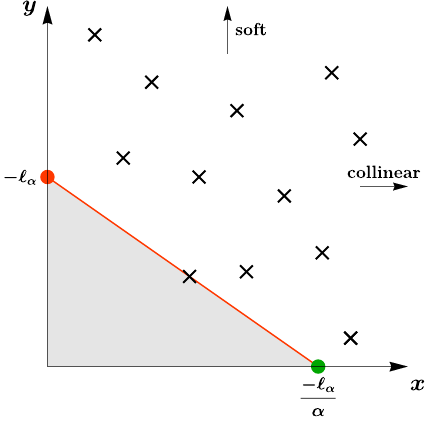
(1 =(cid:18) ) and y = log (1 =z ). The crosses 10 10